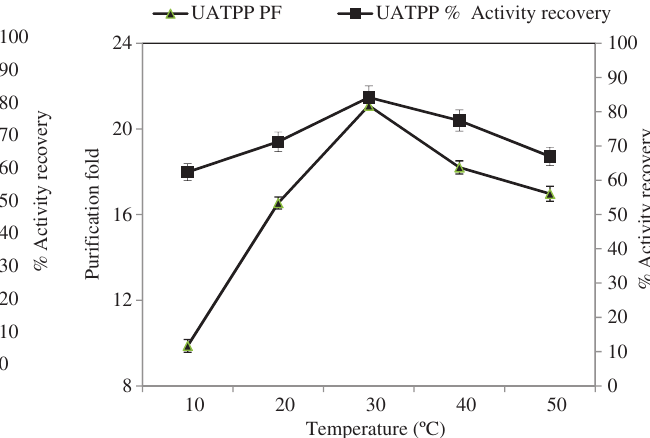
Figure 4: Effect of temperature on ultrasound assisted three phase partitioning (UATPP) of